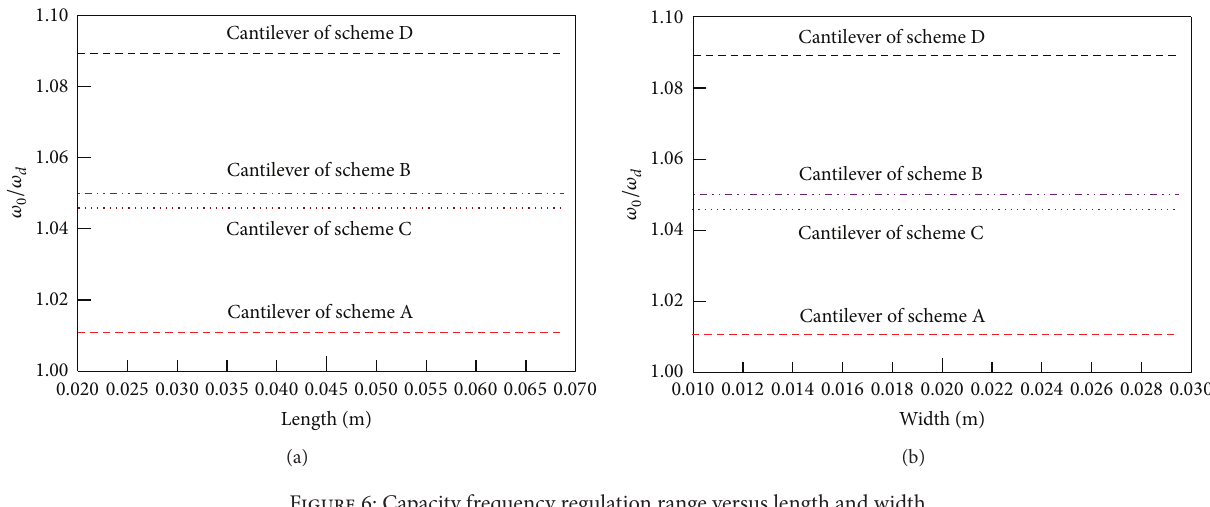
Figure 6: Capacity frequency regulation range versus length and width.